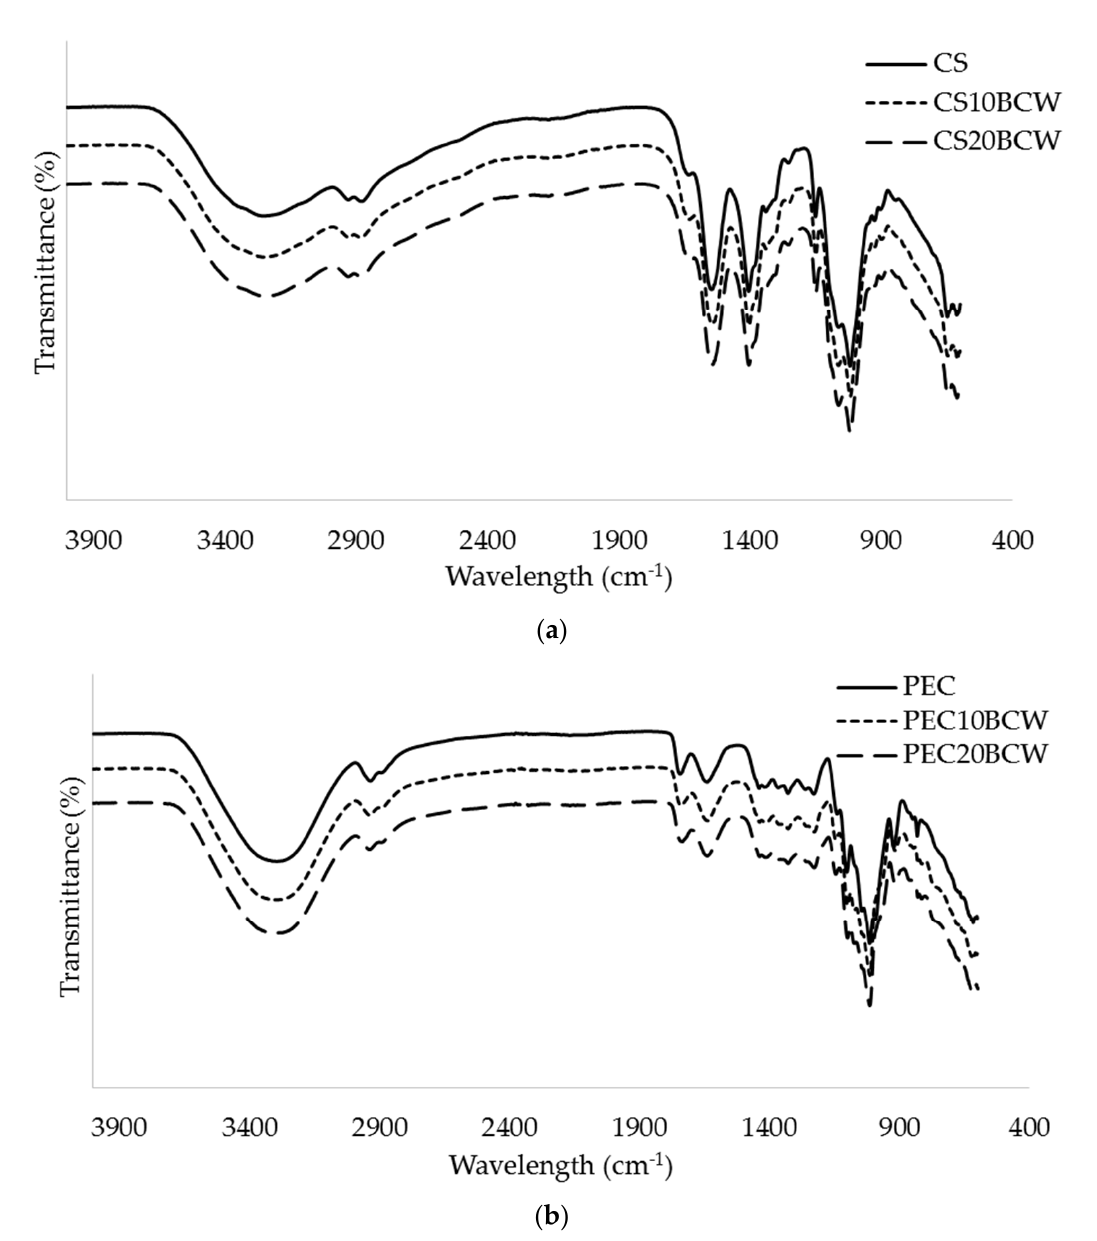
Figure 1. FTIR spectra of chitosan ( a ) and pectin ( b ) without or with blackcurrant powder (BCW). CS-chitosan, CS10BCW and CS20BCW-chitosan with 10 and 20% ( w / w ) blackcurrant powder, PEC-pectin, PEC10BCW and PEC20BCW-pectin with 10 and 20% ( w / w ) blackcurrant powder.